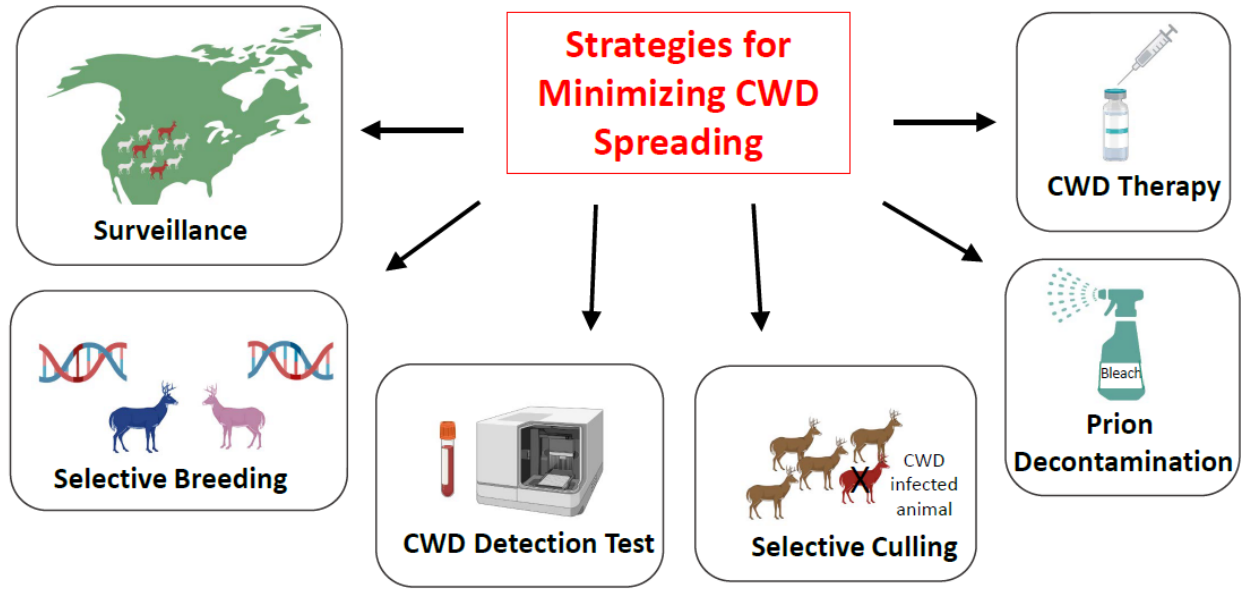
Figure 3. An overview of various strategies to minimize CWD spreading. Various alternative approaches have been proposed to decrease the risk of further CWD spreading, including detailed surveillance, selective breeding of animals harboring rare polymorphisms partially resistant to CWD, development of a highly efficient test for CWD detection, selective culling of infected animals, prion decontamination, and development of a treatment for CWD.